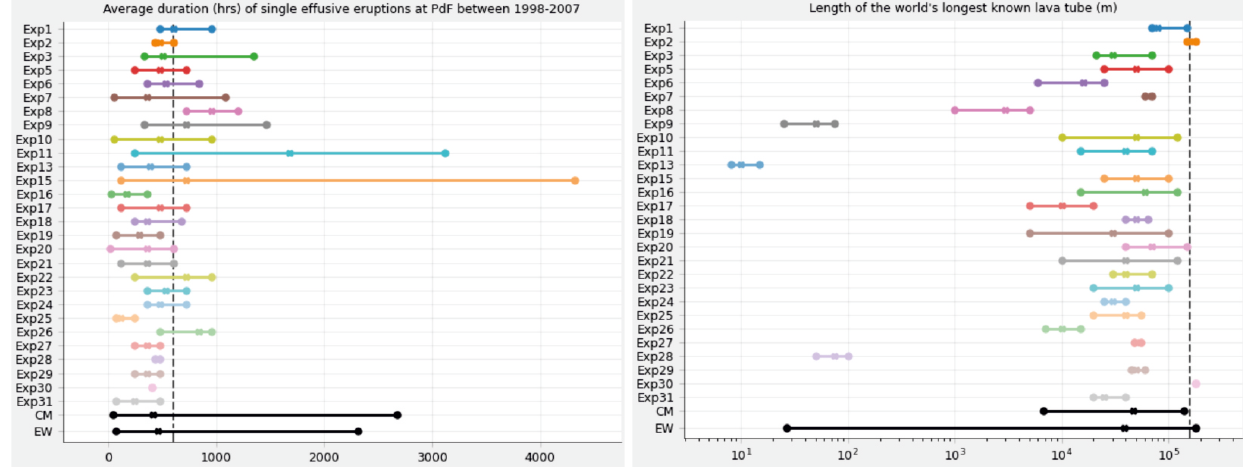
Figure 4: Itemwise graphs for Q9 (left) and Q15 (right) seed questions. “CM” and “EW” are the Decision Maker’s distribution referred to, respectively, as the Classical Model (CM) and Equal Weight (EW) methods. The vertical dashed lines represent the realizations of the seed